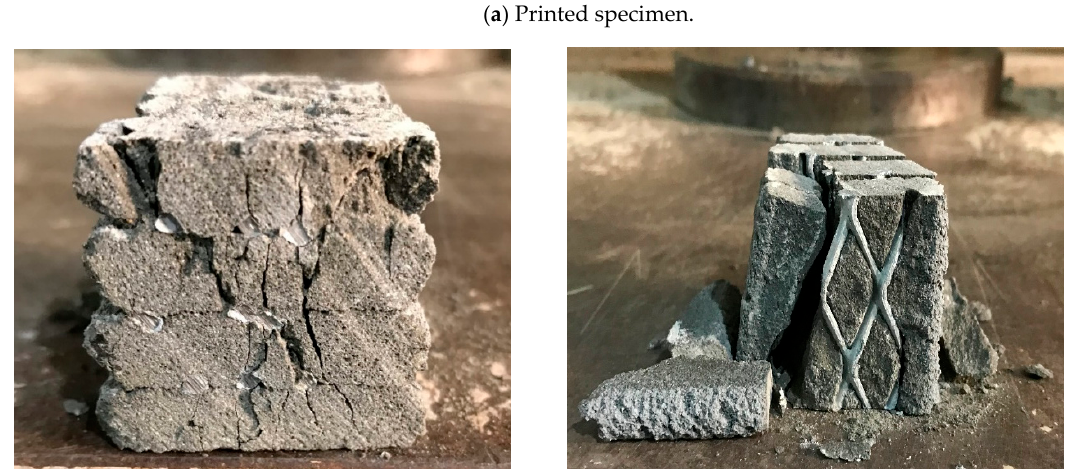
Figure 9. Compressive failure of a printed specimen with and without metal lath in loading directions I and II.